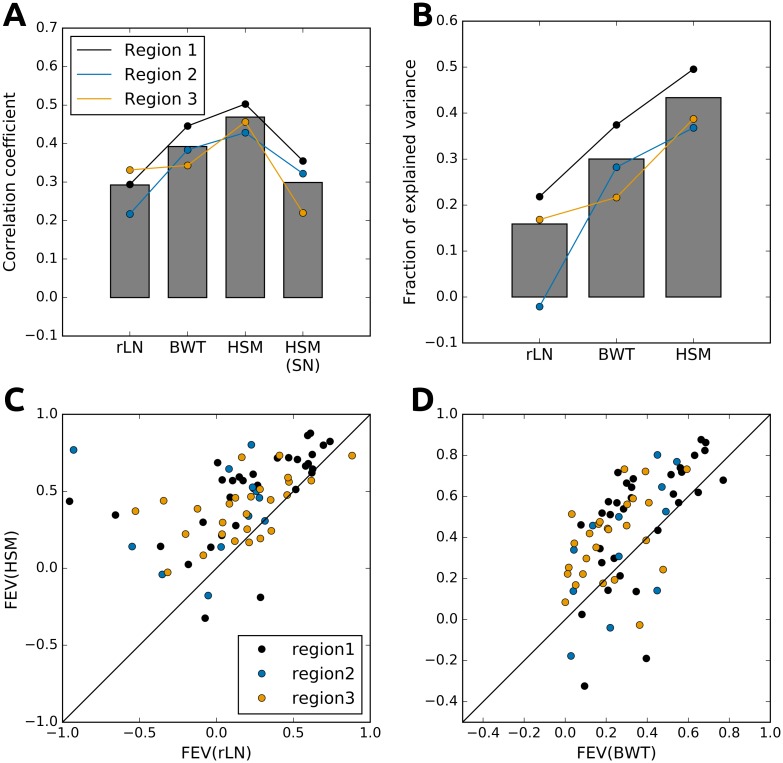
RFs estimated by HSM explain neuronal responses significantly better than existing methods.(A) The average correlation coefficients of the rLN, BWT and HSMs, and of an HSM in which each neuron has been fitted individually HSM(SN). (B) The average fraction of explained variance (FEV) for the three compared models. (C) Scatter plot of the FEV of individual neurons by the rLN and HSMs. (D) Scatter plot of the FEV of individual neurons under the BWT and HSMs. Data from individual regions are marked by the colored lines and/or dots while the averages across regions are indicated as bars.